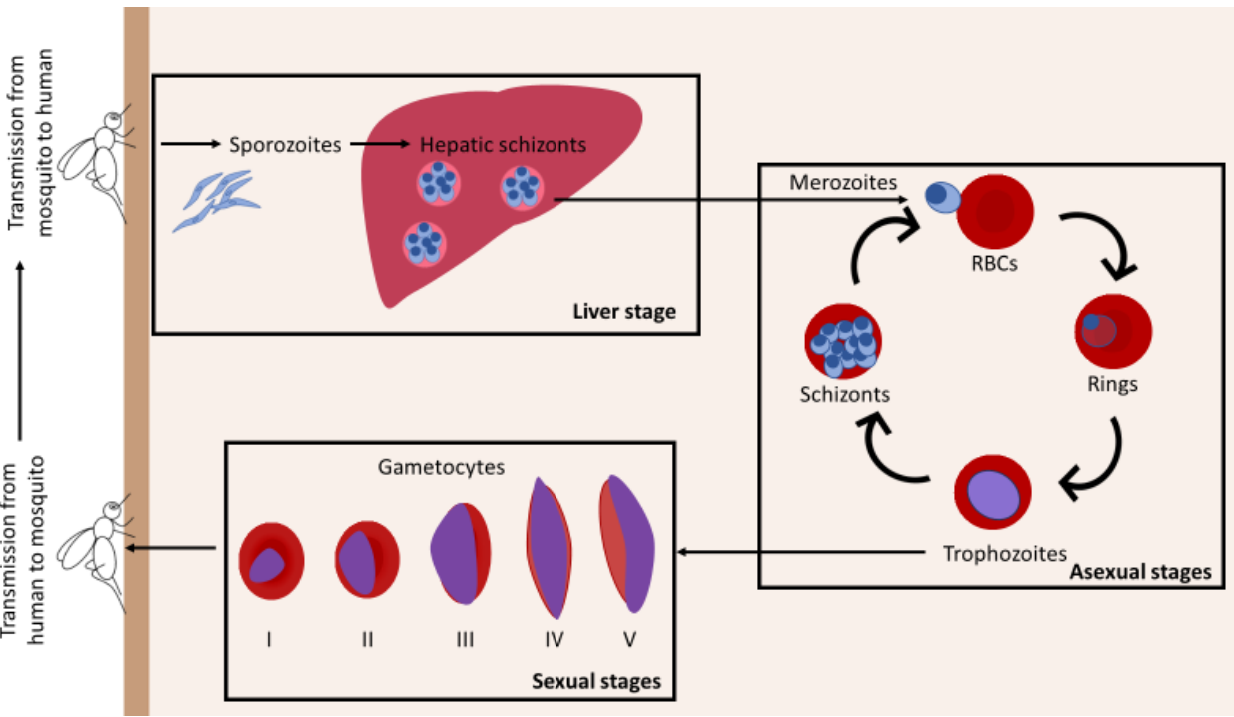
Figure 1. Plasmodium life cycle. During its meal, infected female Anopheles inject sporozoites into human beings. Sporozoites reach the liver and multiply for several days, resulting in the release of merozoites into the bloodstream. Then, merozoites invade RBCs and mature from rings to trophozoites and schizonts (asexual stages). A small portion of parasites differentiates in gametocytes (sexual stages). Gametocyte development is divided into five morphological stages (I–V), I–IV are sequestered in the BM and stage V is released into the peripheral blood, enabling the transmission to the mosquito.